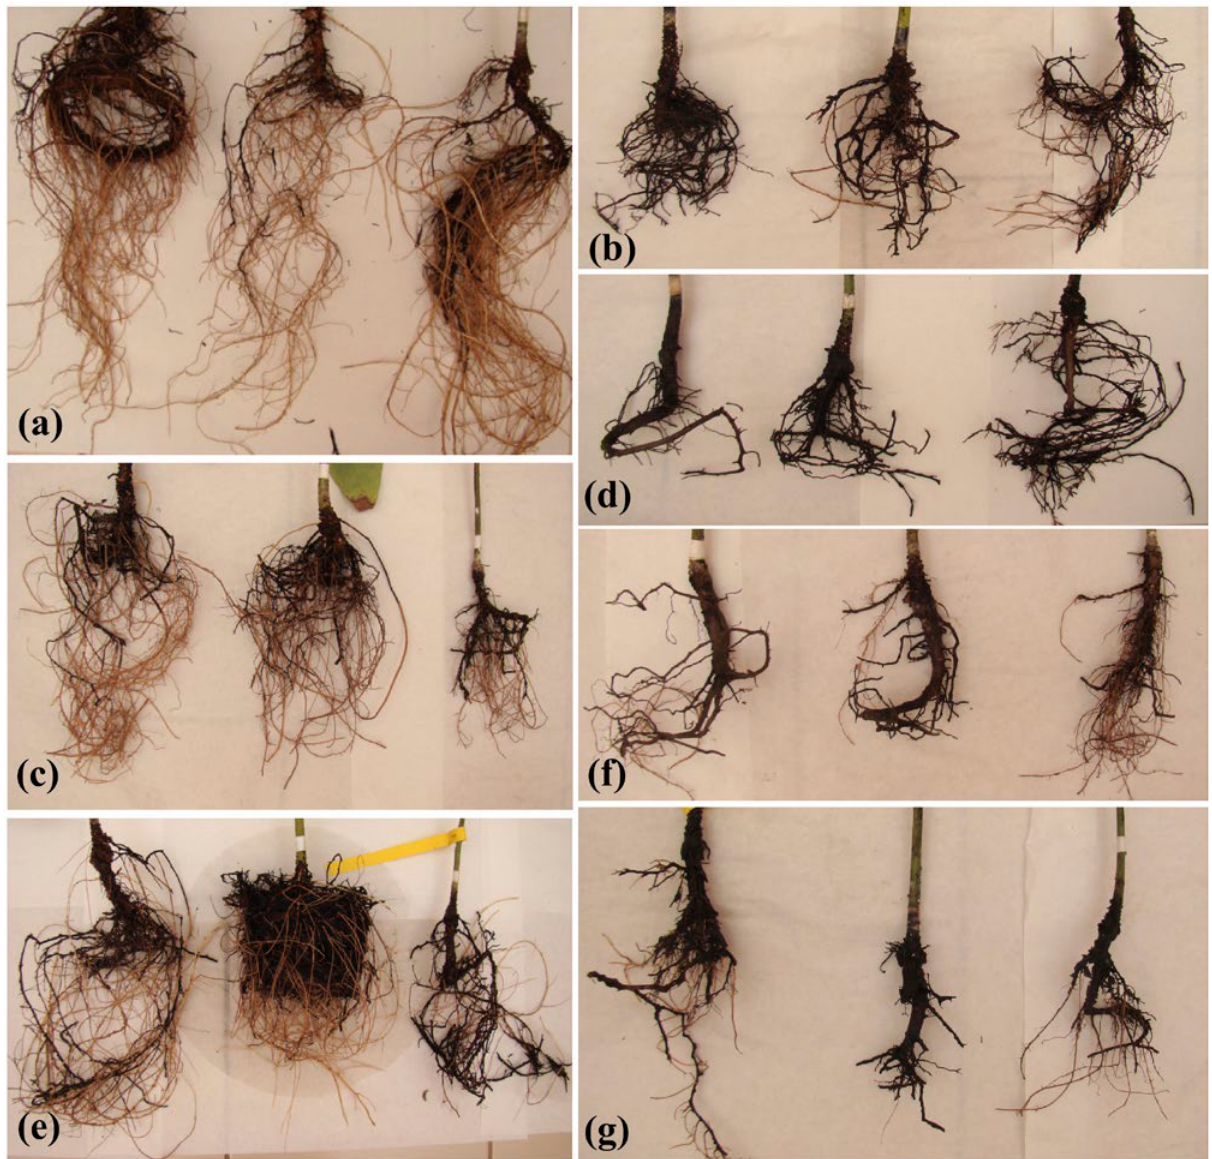
Figure 6. Root rot symptoms in avocado seedlings at the end of the root pathogenicity test under hydroponic conditions: a, Control (uninoculated plants); b, Positive control ( P. cinnamomi isolate PcH15); c, P. palmivora C011; d, P. niederhauserii C052; e, P. multivora C005; f, P. nicotianae C013; g, Pp. vexans